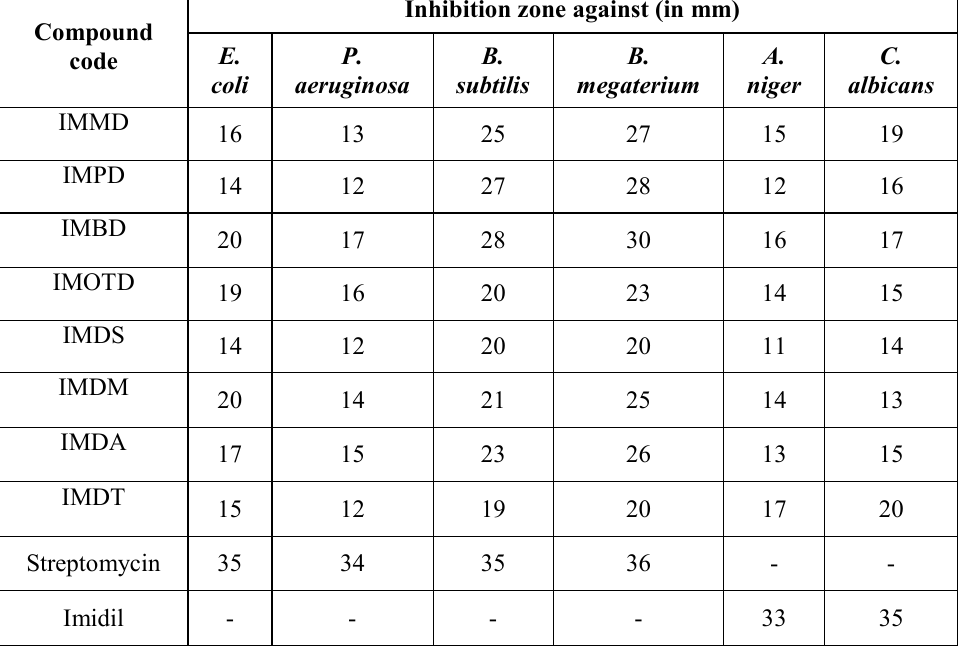
Table 3 . Antimicrobial activity of